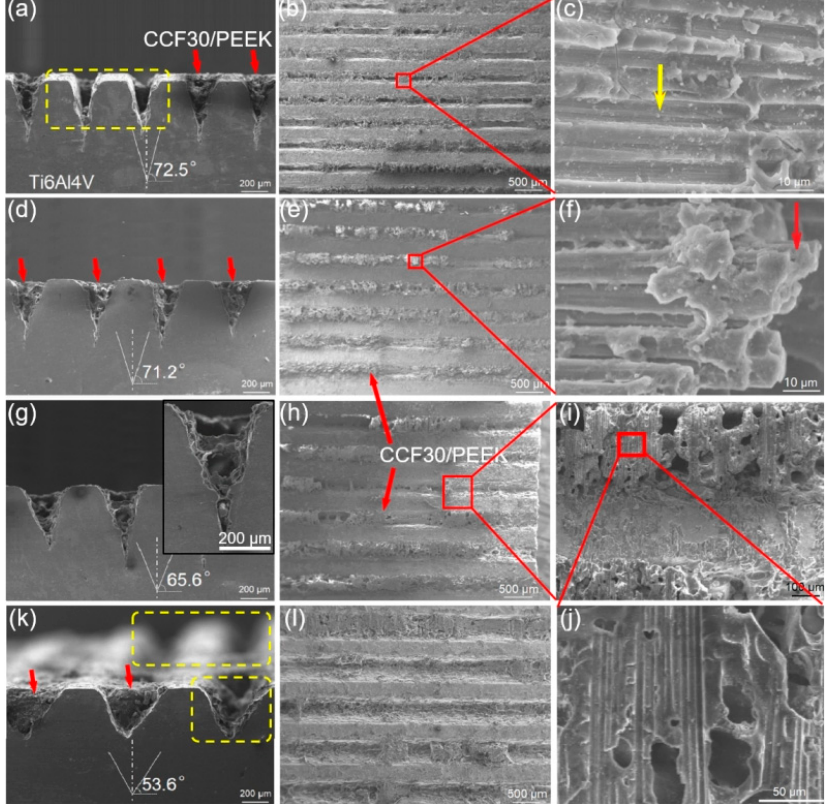
Figure 7. Fracture surface morphology of typical CCF30/PEEK-Ti6Al4V joints after tensile tests under the condition of microgroove orientation of 0°. The microgroove width was 225 ± 15 μ m ( a – c ), 265 ± 10 μ m ( d – f ), 335 ± 10 μ m ( g – j ), and 425 ± 15 μ m ( k , l ), respectively. Similarly, the typical fracture surfaces of CCF30/PEEK-Ti6Al4V joints with 90° grat- ings pre-textured on Ti6Al4V surface are displayed in Figure 8. From the morphologies of the fractured Ti6Al4V surfaces, it was observed that all the joints fractured mainly by co- hesive failure, that is, the carbon fibers were detached from PEEK resins. In the case of the microgroove width of 225 ± 15 μ m, fracture occurred near the joining interface with the